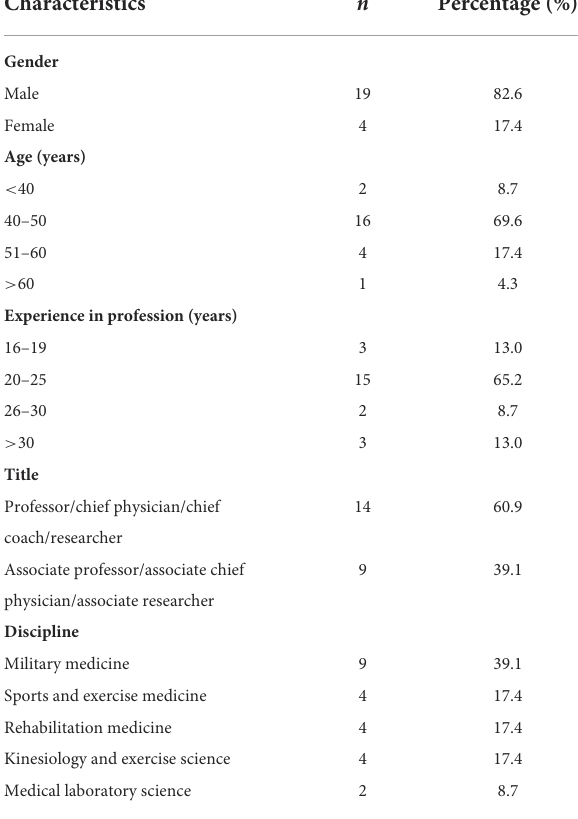
TABLE 1 Demographic characteristics of Delphi panel ( N =